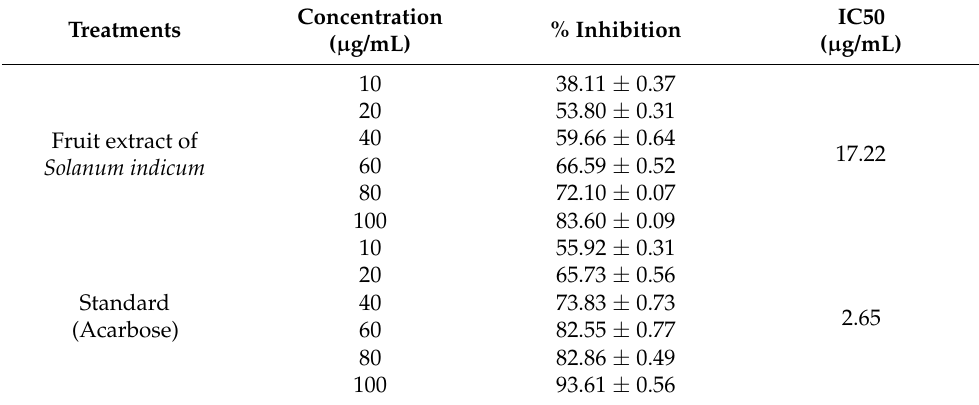
Table 2. α -Amylase inhibition assay.